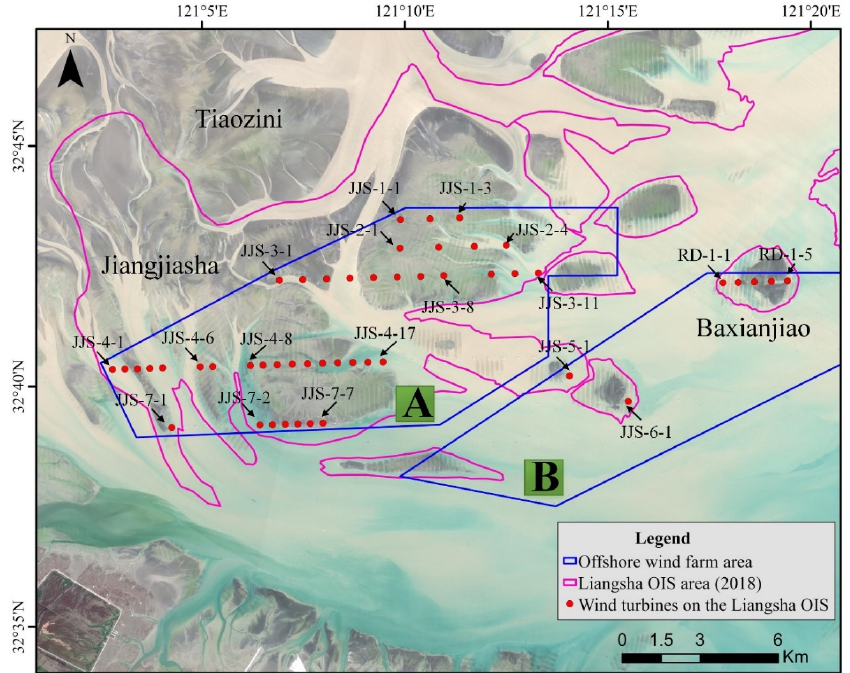
Figure 2. Spatial distribution of 49 offshore wind turbines in the Liangsha OIS. The irregular poly- gons labeled A and B are the regions of the Jiangjiasha 300-MW and Huaneng Rudong 300-MW offshore wind farms, respectively.